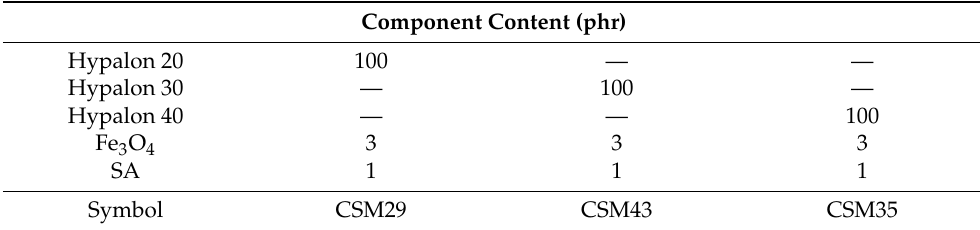
Table 1. The formulations of the composites used in the first series of tests.